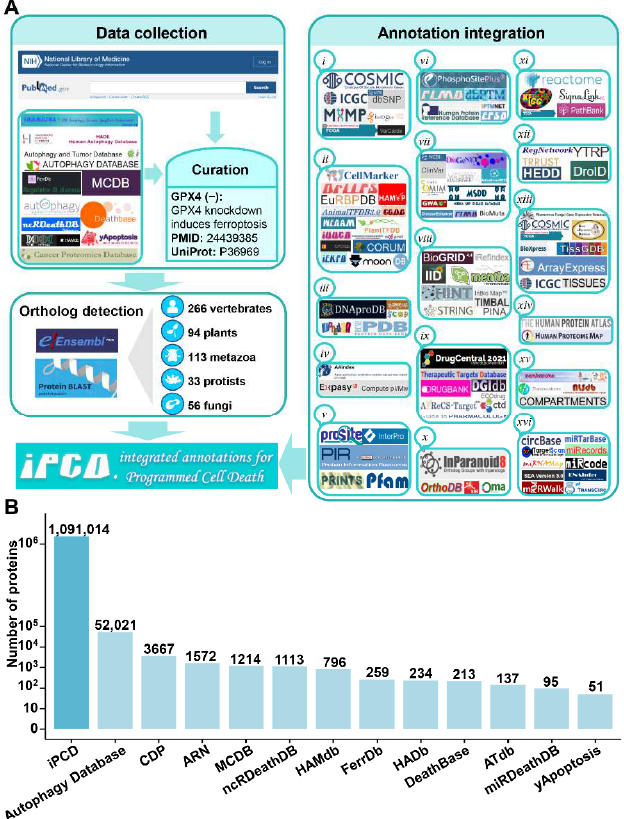
Figure 1. The procedure for the construction of iPCD and the comparison between iPCD and 12 additional databases. ( A ) The workflow for the construction of the iPCD database. First, we collected 30 experimentally identified forms of PCD proteins from PubMed and annotated them ‘+’ or ‘−’ as positive or negative PCD regulator. Then, 11 additional PCD databases were merged and carefully re-curated for each entry, and further conducted an orthologous search to computationally identify new PCD regulators in 562 eukaryotes. Next, the PCD regulators were annotated with 102 additional public resources in 8 model organisms that covered 16 aspects. ( B ) The numbers of PCD proteins included in iPCD and 13 additional